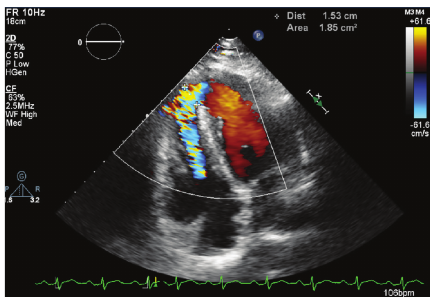
Figure 1: Transthoracic echocardiogram: apical ventricular septal defect with shunt noted.